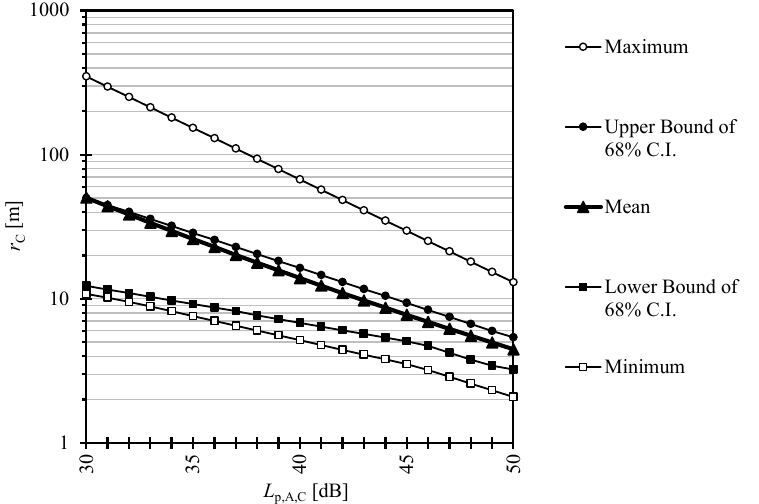
Figure 4. The range of comfort distance values, r C , as a function of the comfort criterion level, L p,A,C , for the 26 offices of Ref. [17] calculated by Equation (2). Mean, maximum, minimum, and 68% confidence interval (C.I.) within the sample of 26 offices are shown.